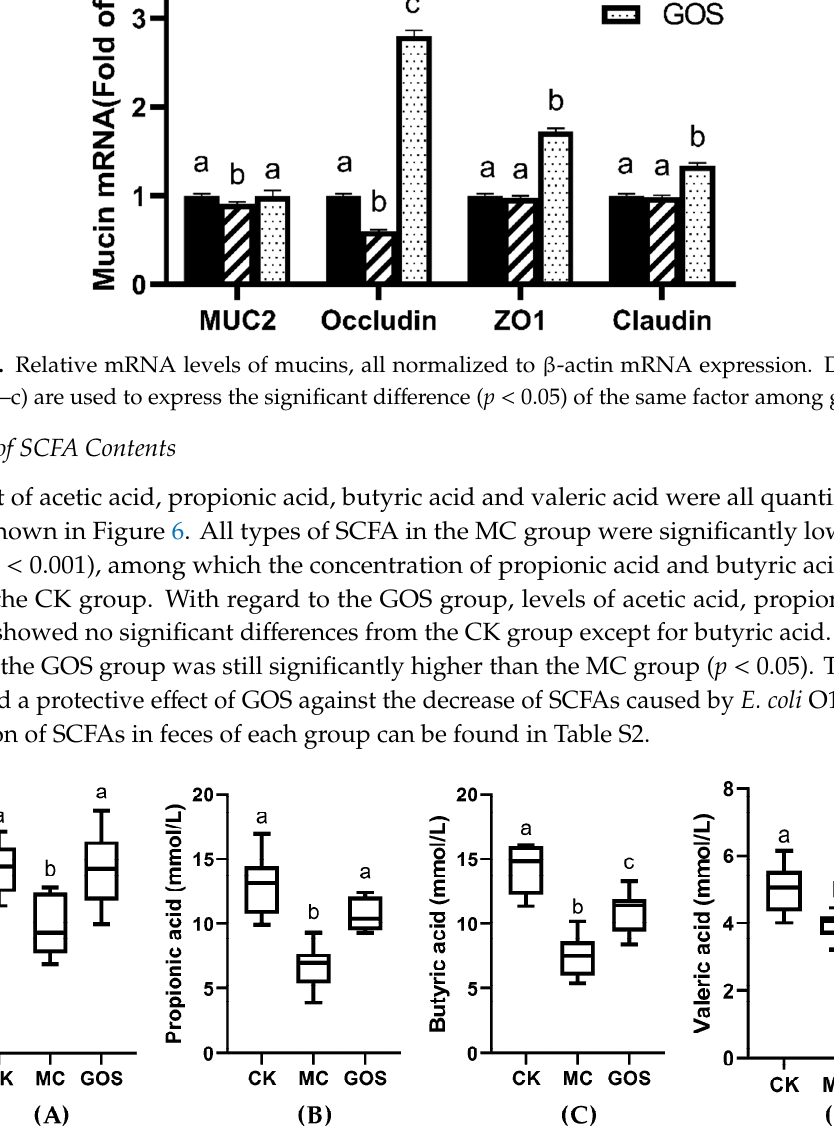
Figure 6. Concentrations of various short-chain fatty acids (SCFAs) in feces after infection. ( A ) Acetic acid; ( B ) Propionic acid; ( C ) Butyric acid; ( D ) Valeric acid. Different letters (a–c) are used to express the significant differences ( p < 0.05) between various short chain fatty acids (SCFAs).